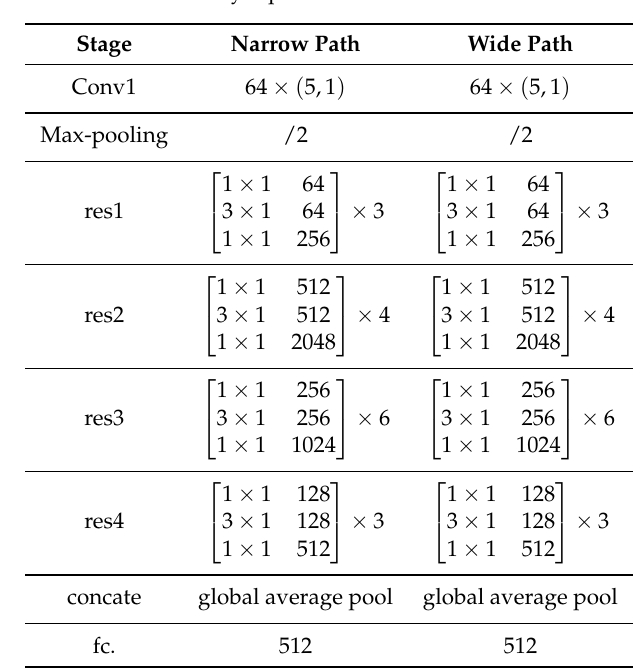
Table 2. The layer parameters of the ARN